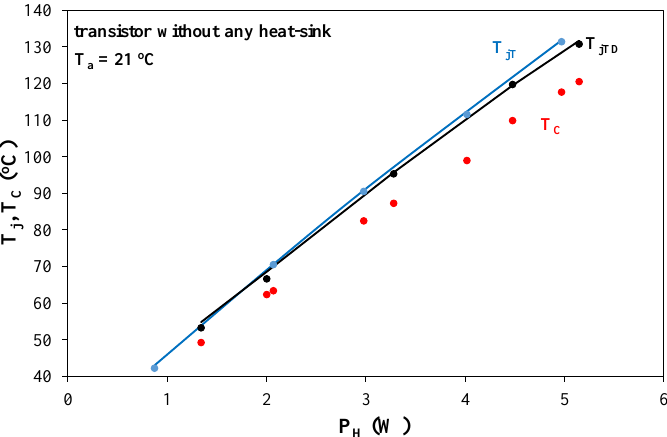
Figure 12. Measured and computed dependences of internal and case temperature of the investigated transistor operating without any heat-sink on heating power dissipated in the transistor. As can be observed, all the considered dependences are increasing functions. Differ- ences between values of the considered device increase together with an increase in